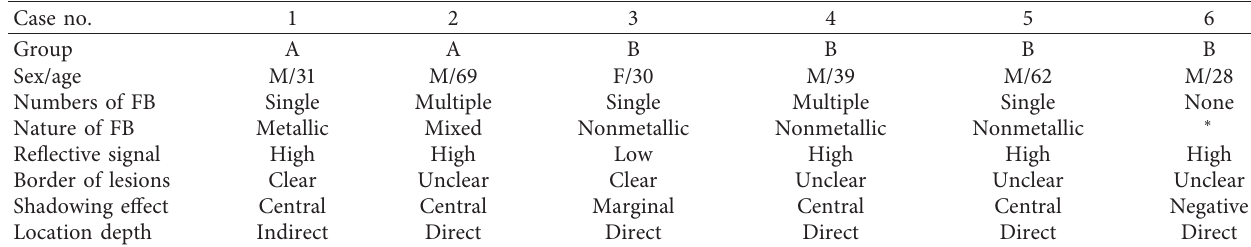
Table 2: Clinical details and AS-OCT characteristics of cases.